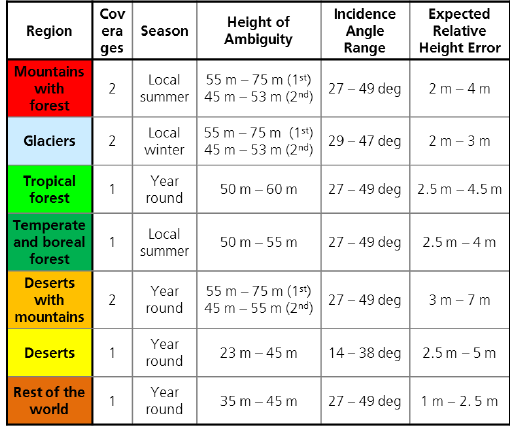
Table 1. Acquisitions parameters and expected relative